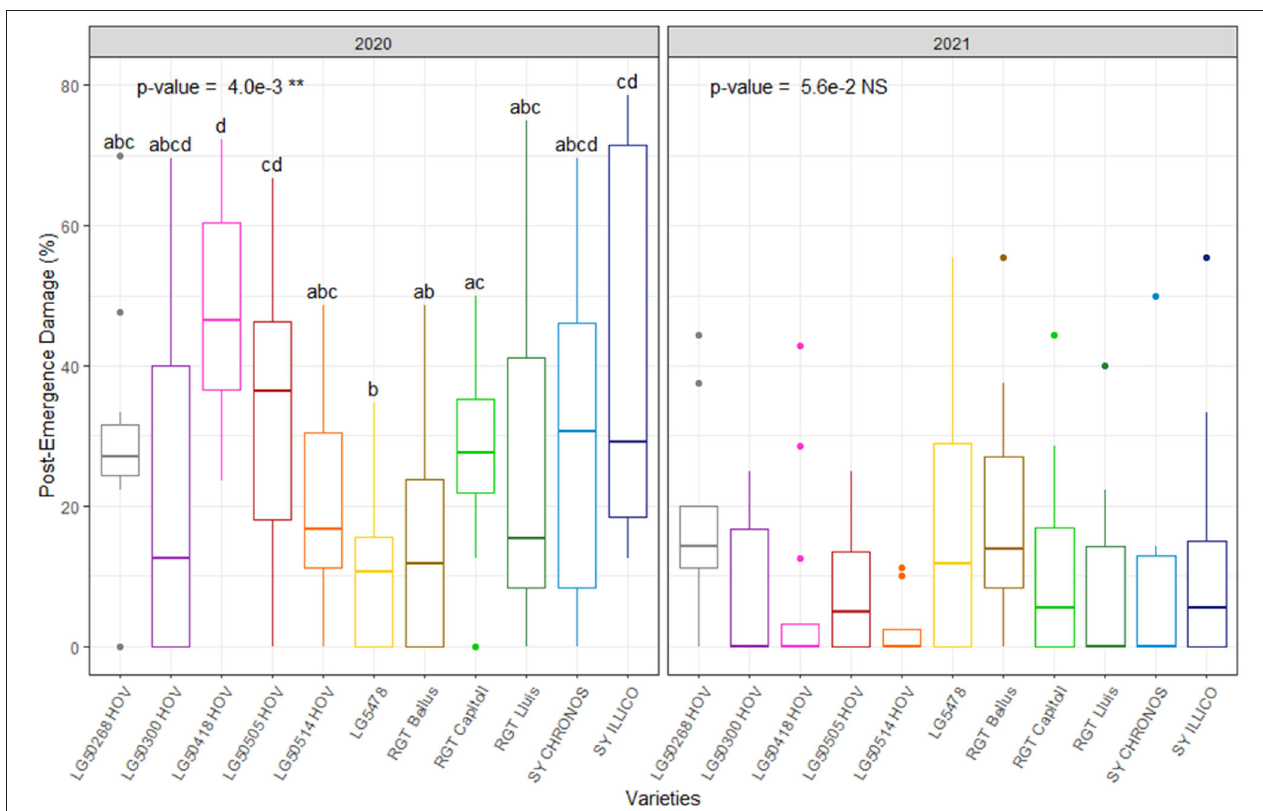
FIGURE 8 | Rates of postemergence damage due to pigeons on the 11 hybrid oilseed varieties of sunflower over the two experimental years, 2020 and 2021 at the Auzeville experimental station. Vertical bars reported in the figure represent confidence intervals. The different letters indicate a significant difference between the tested